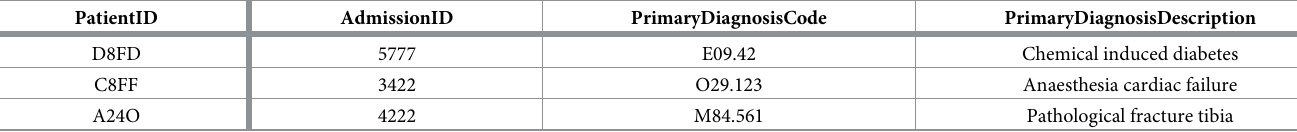
Table 3. Illustration of the patient’s EHRs.